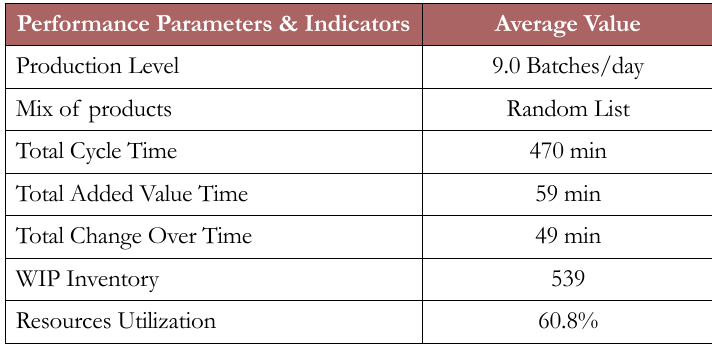
Table 7. Manufacturing Performances of JITds